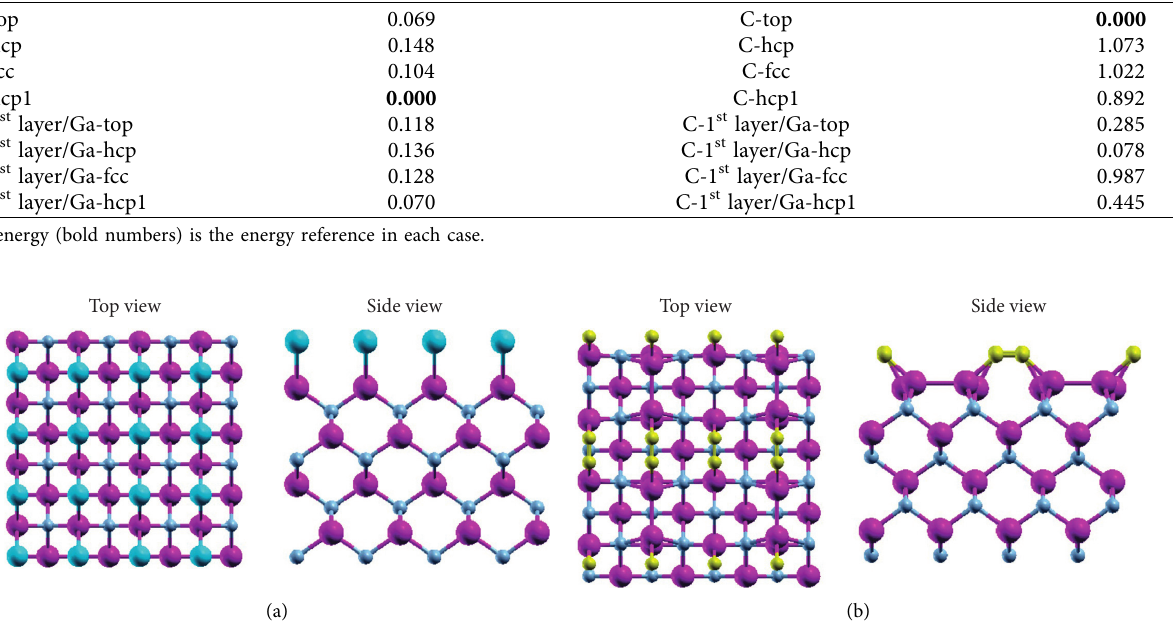
Figure 2: (a) Ge adsorption at the hcp1 site and (b) C adsorption at the top site.